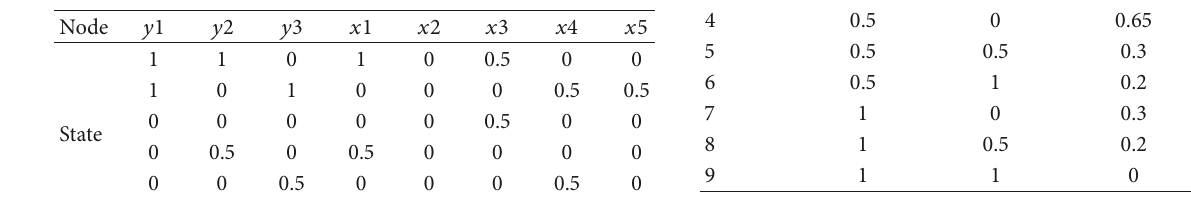
Table 3: Partial characteristic data of fault state of rotor system of some large pumping stations in Jiangsu Province.